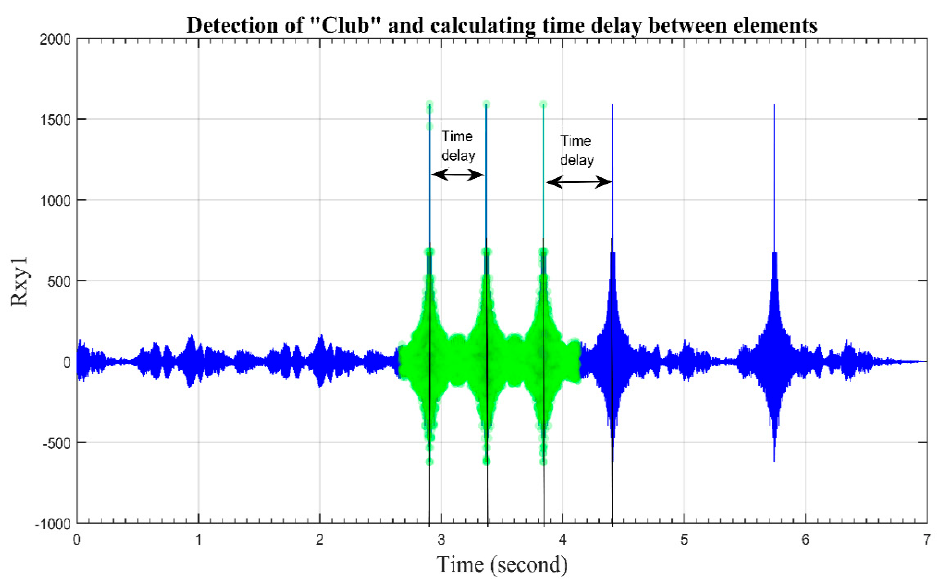
Figure 11. Detection of “club” and calculation of time delay between elements.